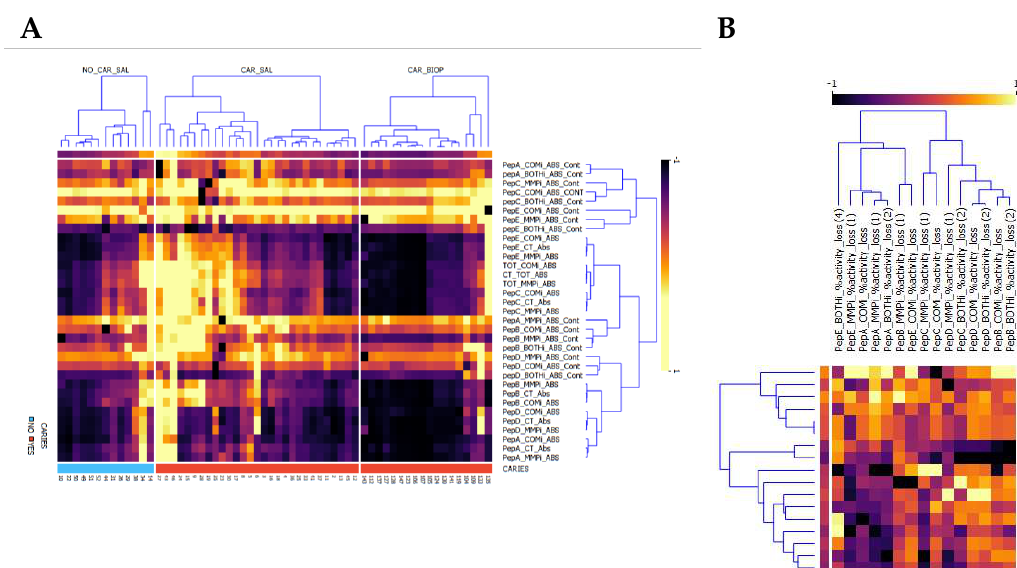
Figure 2. Normalized Pearson Bi-clustered heatmaps, ( A ) split by sample type for all absolute activities and ( B ) inhibitor contributions to turnover. Specimen were saliva (_SAL) samples examined and caries biopsies obtained (CAR_BIOP), representing relative substrate utilization for peptides (PepA–PepE) turnover in relation to overall activity (_CT_ABS) and inhibited contribution to turnover (_ABS_CONT). Inhibitors denote _COMi_ = COMPLETE, _MMPi = Metalloprotease inhibitor or _BOTHi, comprising a combination of both. The respective contribution of inhibitors (CONT) to Vmax is reported. Across all samples, a consistent CSC signal is observed for PepC (PepC_COMi_ABS_CONT). Saliva in caries positive subjects is delineated predominantly by an increase in pepE overall turnover, BOTHi inhibition and the reduced inhibitory effect of COMi and MMPi. The second cluster in caries is defined by the prevalence of increased MMP contribution for PepA and PepB. ( B ) relative inhibition observed for caries biopsies, highlighting the utilization of substrates by both MMP and CSC proteases.